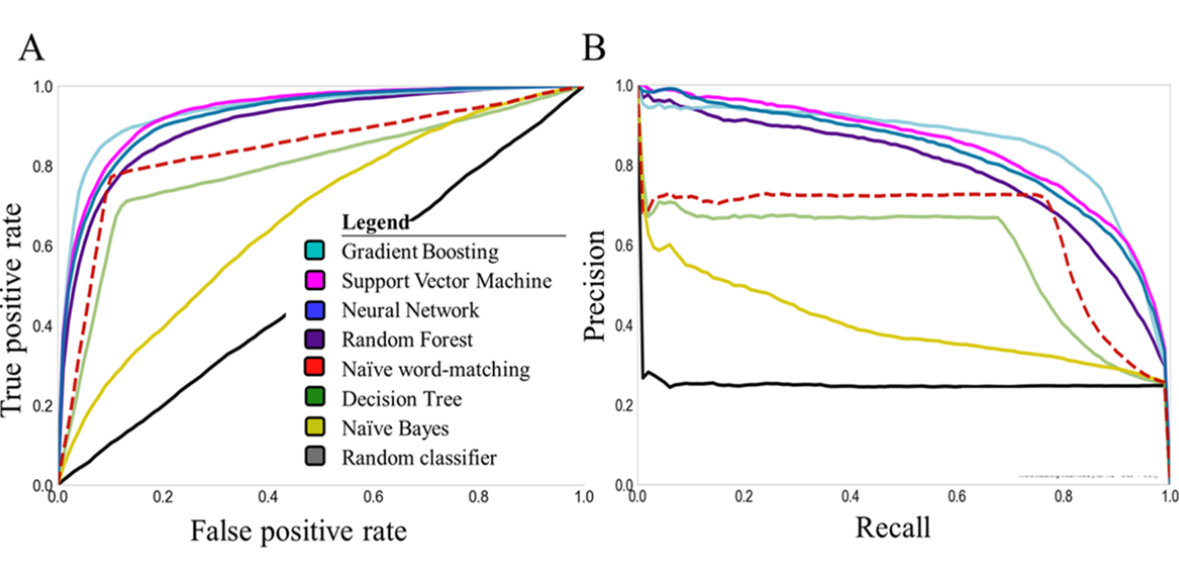
Figure 5. (A) Receiver operating characteristics and (B) precision-recall curves for all machine learning methods (solid lines) and the naïve word-matching method (dotted line) in the training set (Erlangen-A).